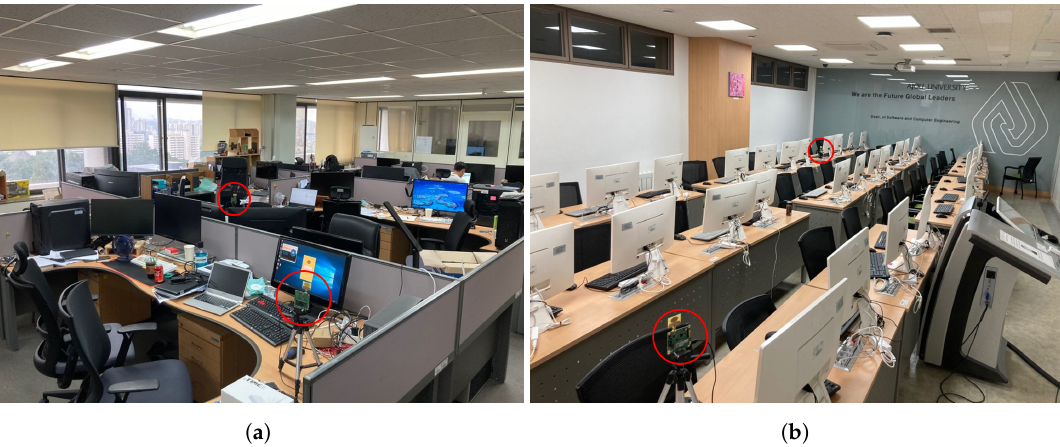
Figure 4. Two rooms in Paldal Hall, Ajou University, used for measuring the UWB channel. ( a ) Laboratory located on the ninth floor of the building; ( b ) classroom located on the third floor.